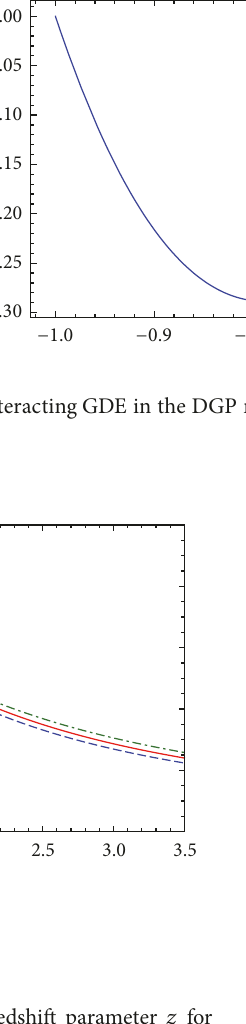
Figure 10: The evolution of Ω 𝐷 versus redshift parameter 𝑧 for interacting GDE in the DGP model. Here, we have taken Ω 𝐷 (𝑧 = 0) = 0.73 , 𝐻(𝑧 = 0) = 67 , and Ω = 0.0003 . 𝑟 𝑐